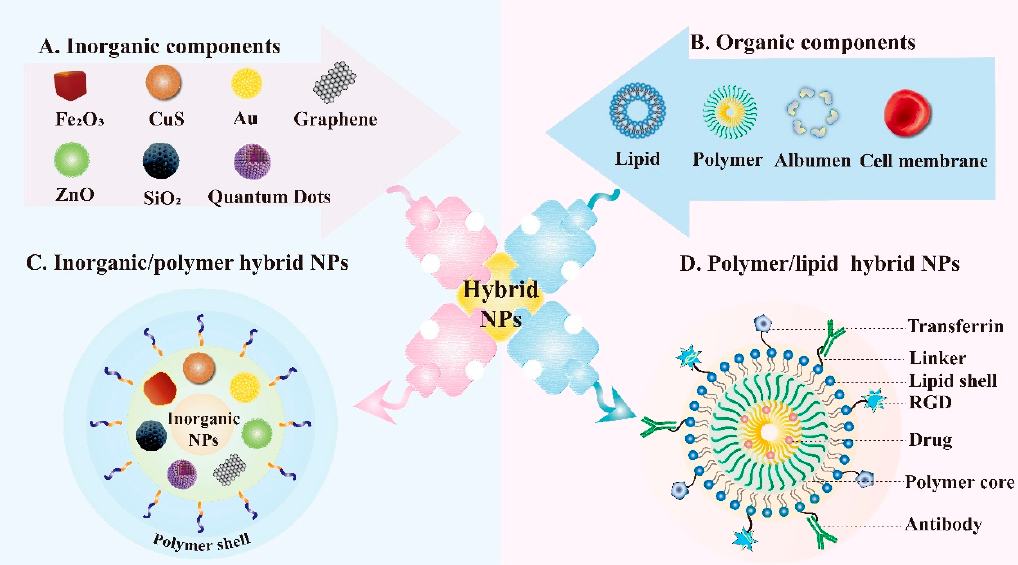
Figure 6. Schematic illustration of hybrid NPs. The representative inorganic nanomaterials ( A ) and organic nanomaterials ( B ) applied in hybrid NPs. ( C ) Composition of inorganic/polymer hybrid NPs. The combination of each type of inorganic core with the corresponding polymer results in hybrid NPs with different properties. ( D ) Structure of polymer/lipid hybrid NPs which consists of a polymer core encapsulating drugs and lipid shell. The lipid shell can also conjugate to a variety of targeting agents like antibodies, arginyl glycyl aspartic acid (RGD) and transferrin to ensure target delivery.